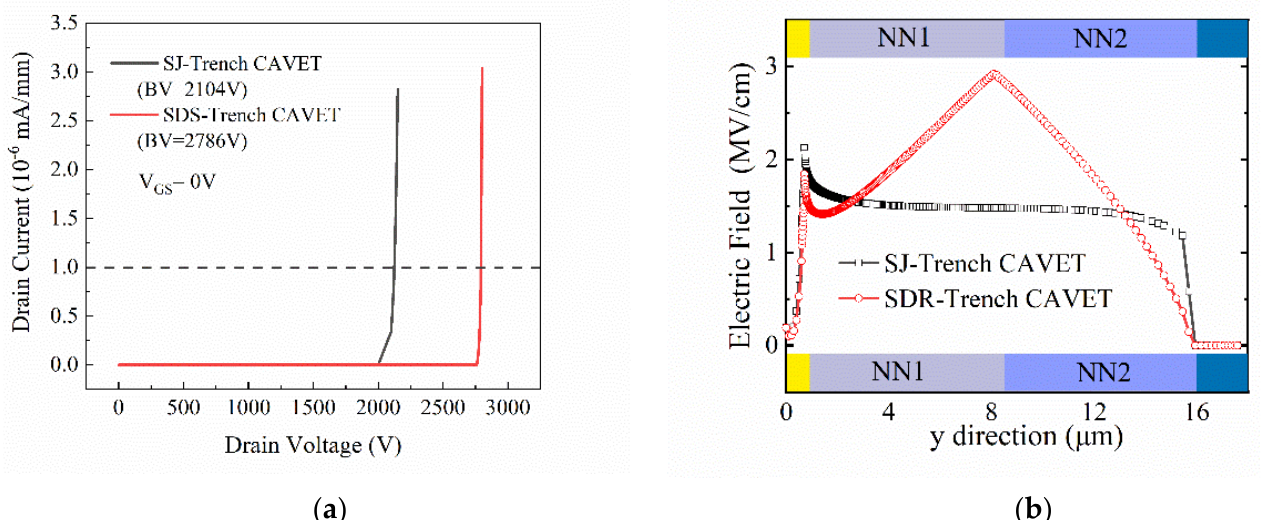
Figure 5. ( a ) Off-state BV curves of SJ-Trench CAVET and SDS-Trench CAVET and ( b ) electric-field strength comparison in the GaN drift along line L3L4.